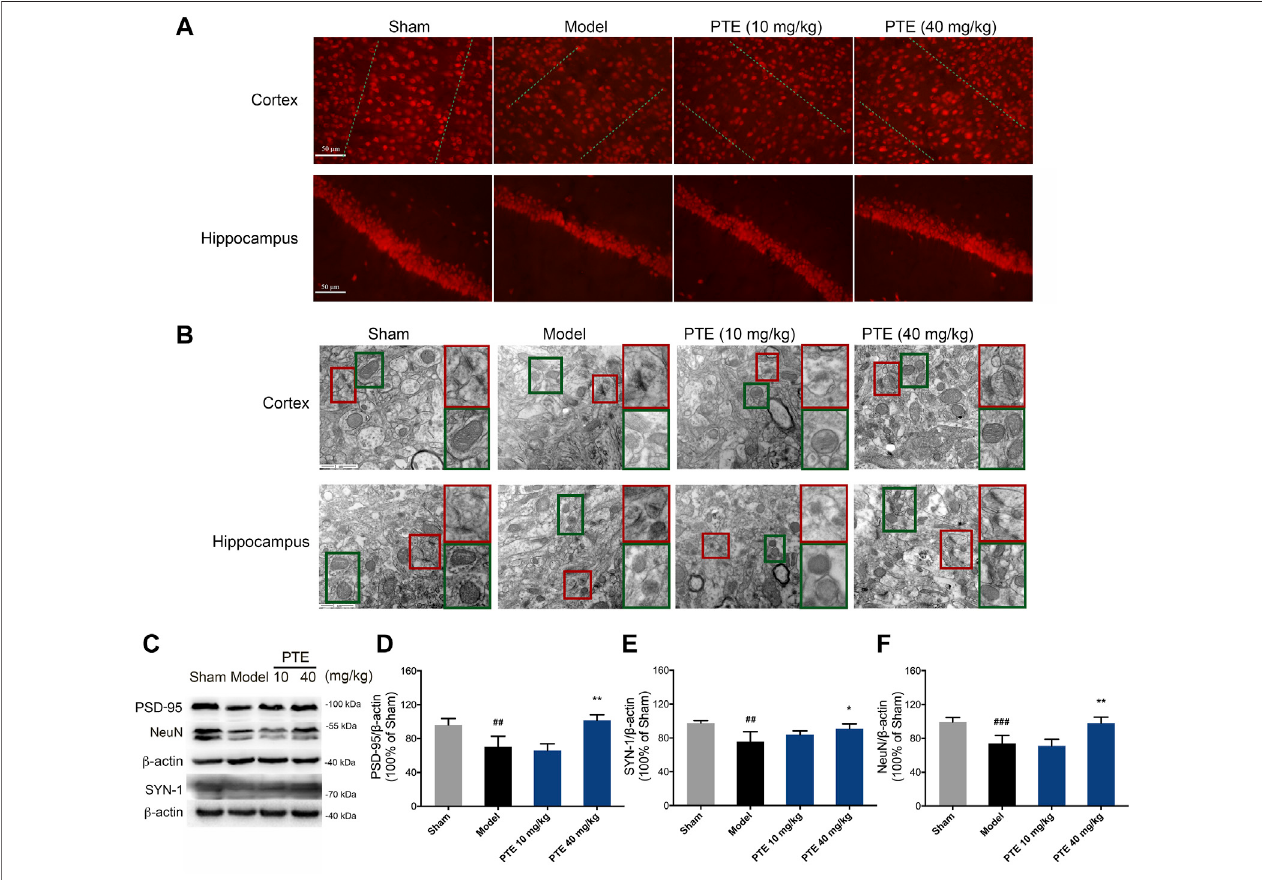
FIGURE 5 | Effects of PTE on neuronal and mitochondrial injury in AD mice. (A) NeuN-positive cells in the cerebral cortex and hippocampus were detected by immuno fl uorescence. (B) Representativetransmissionelectronmicroscopyimagesshowingthesynaptic(redsquare)andmitochondrialstructures(greensquare)inthe cerebral cortex and hippocampus. (C – F) Western blotting bands (C) and quantitative analysis of synaptic plasticity-related proteins PSD-95 (D) , SYN-1 (E) , and NeuN (F) in the cerebral cortex of mice. Data are shown as mean ± SD (n = 3 – 4). ## p < 0.01, ### p < 0.001 vs sham; * p < 0.05, ** p < 0.01 vs model.